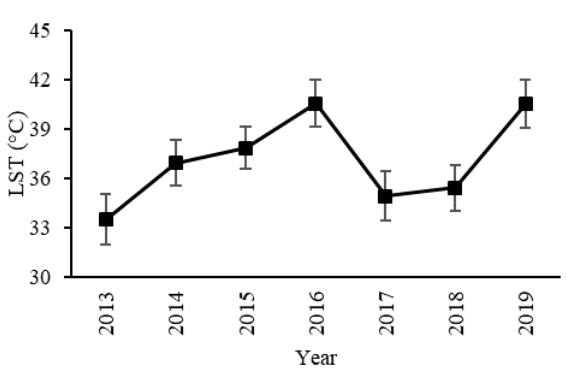
Figure 4. Annual average LST in Mandaue City,